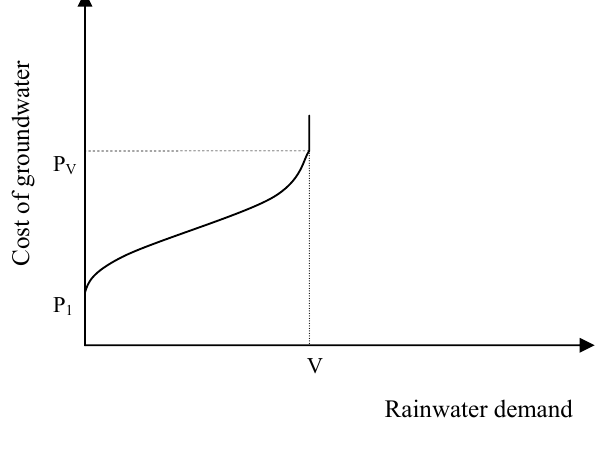
Figure 5. The relation between groundwater cost and rainwater demand. (V means rainwater